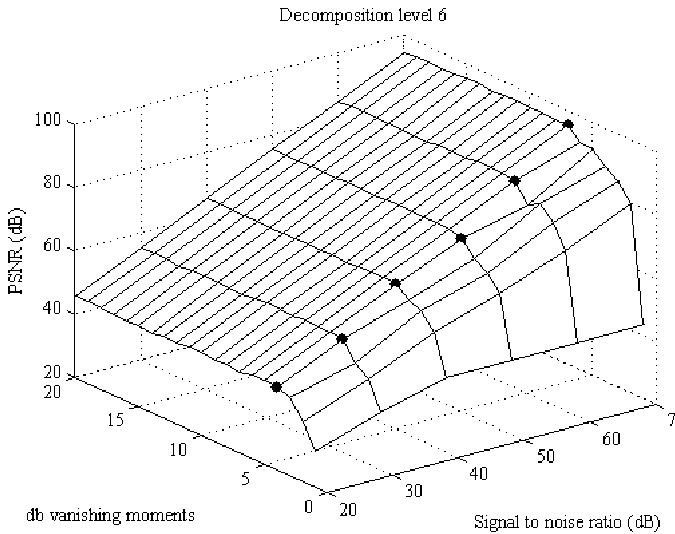
Figure 6. Noise reduction as a function of wavelet vanishing moments and SNR for 6 th decomposition